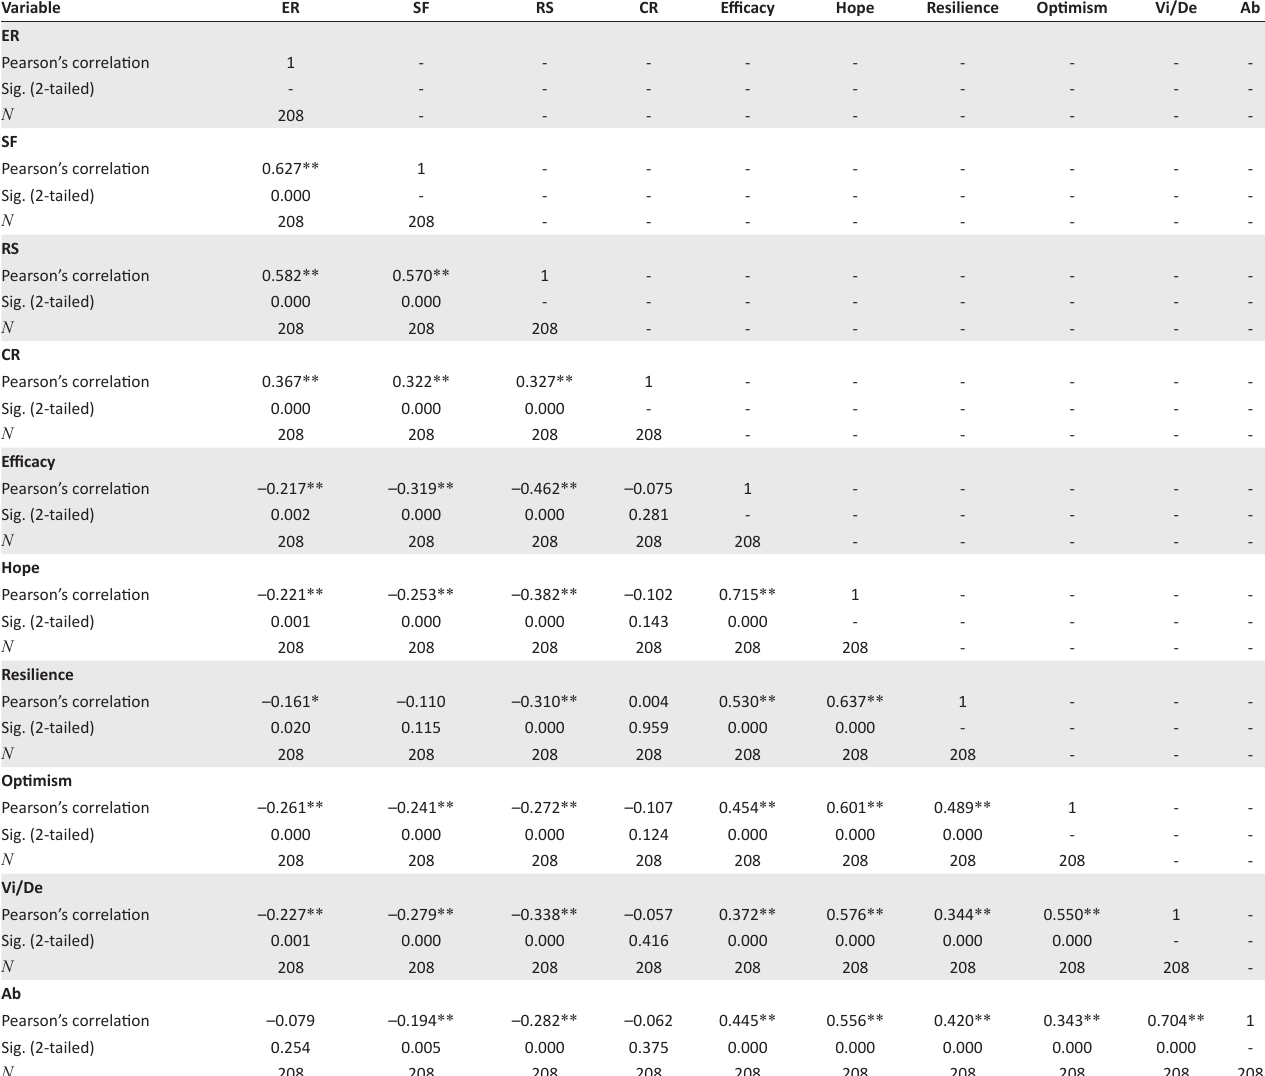
TABLE 3: Pearson’s product moment correlation coefficients on the total constructs of resistance to change, work engagement (Vi/De, Ab) and PsyCap ( n = 208). Variable